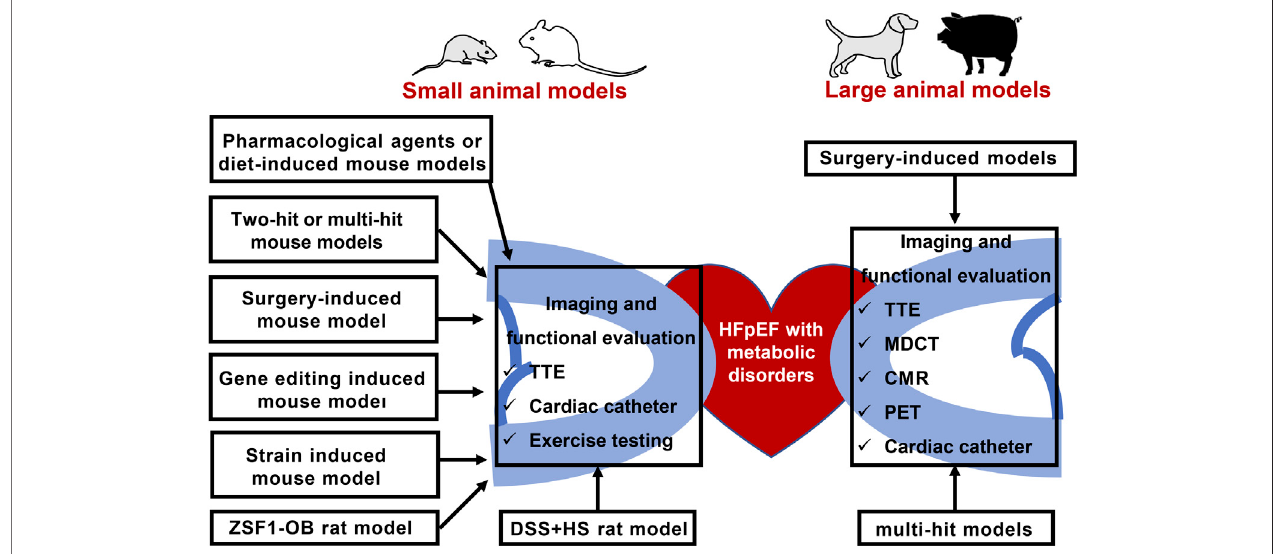
FIGURE 2| Animal models ofHFpEF and metabolic disorders, as well as the imaging and functional modalities for animal cardiac assessment. TTE: Transthoracic echocardiography; HFpEF: heart failure with preserved ejection fraction; ZSF1-OB: Obese diabetic Zucker fatty/spontaneously hypertensive heart failure F1 hybrid rats; DSS + HS: salt-sensitive rats on a high-salt diet; PET: positron emission tomography; MDCT: multidetector computed tomography; CMR: cardiovascular magnetic